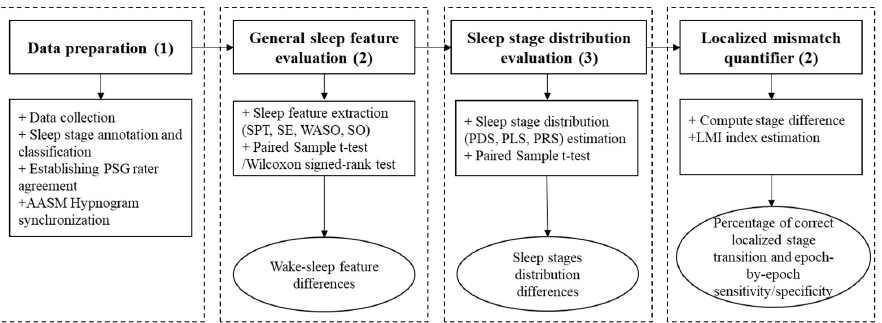
Figure 1. Overall description of the proposed evaluation framework.